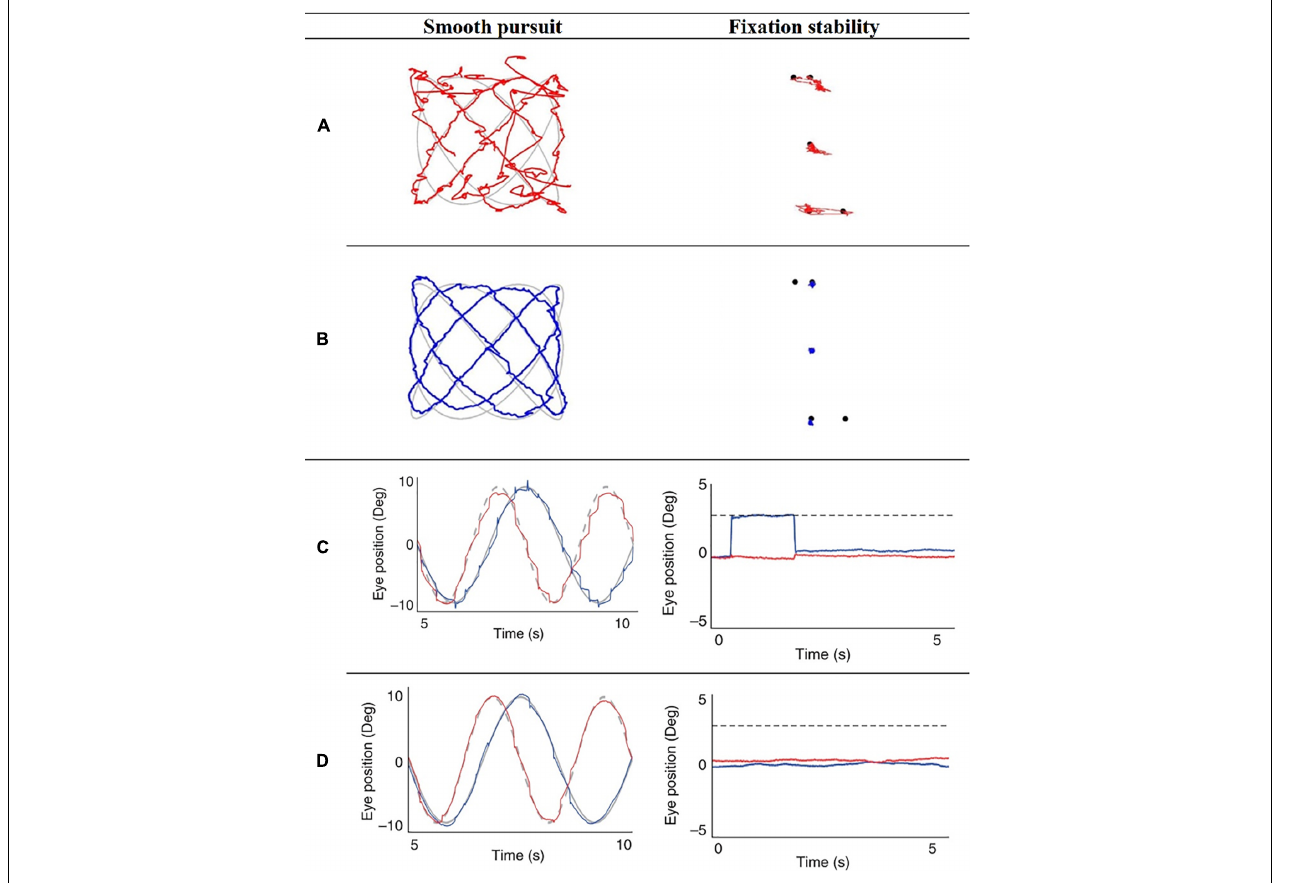
FIGURE 2 | Ilustrative eye-movement recordings of pursuit and fixation stability tests of schizophrenia (SZ) patients and healthy controls (HC), obtained from Benson et al. (2012) and Morita et al. (2017). Importantly, the reader should bear in mind that not every participant will exhibit “normal/abnormal” eye-movements on every trial nor on each task. Illustrative Lissajous pursuit and fixation stability tests of SZ patient (A) and HC (B) , obtained from Benson et al. (2012). Representative eye-movement recordings of a patient with SZ (C) and one HC (D) , during the smooth pursuit eye movement test (fast Lissajous paradigm) and the fixation stability test (far distractor paradigm), obtained from Morita et al.